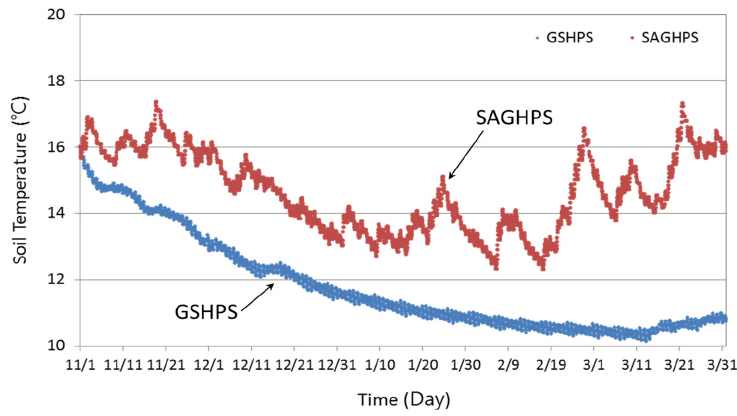
Figure 7. The diversification of soil temperature with different systems.